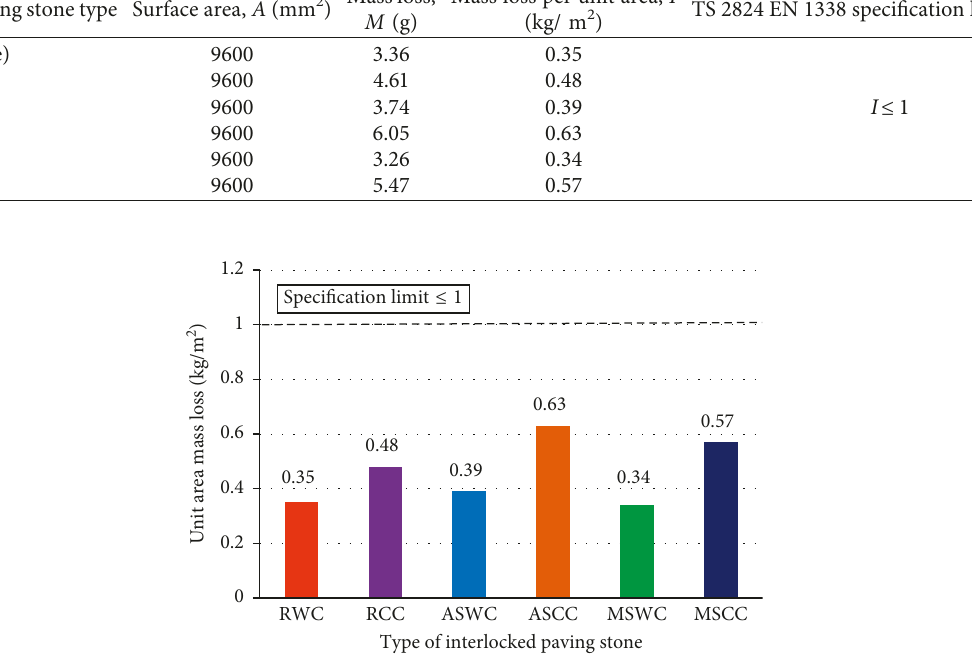
Figure 13: Results of the freeze-thaw test for the interlocked paving stones. Table 21: All test results of interlocked paving